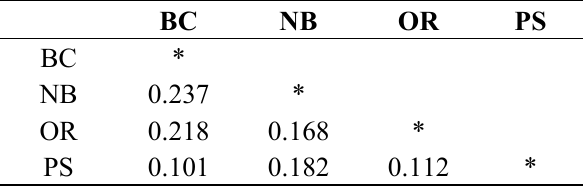
Table 2. Population structure: F ST matrix for sampled populations.